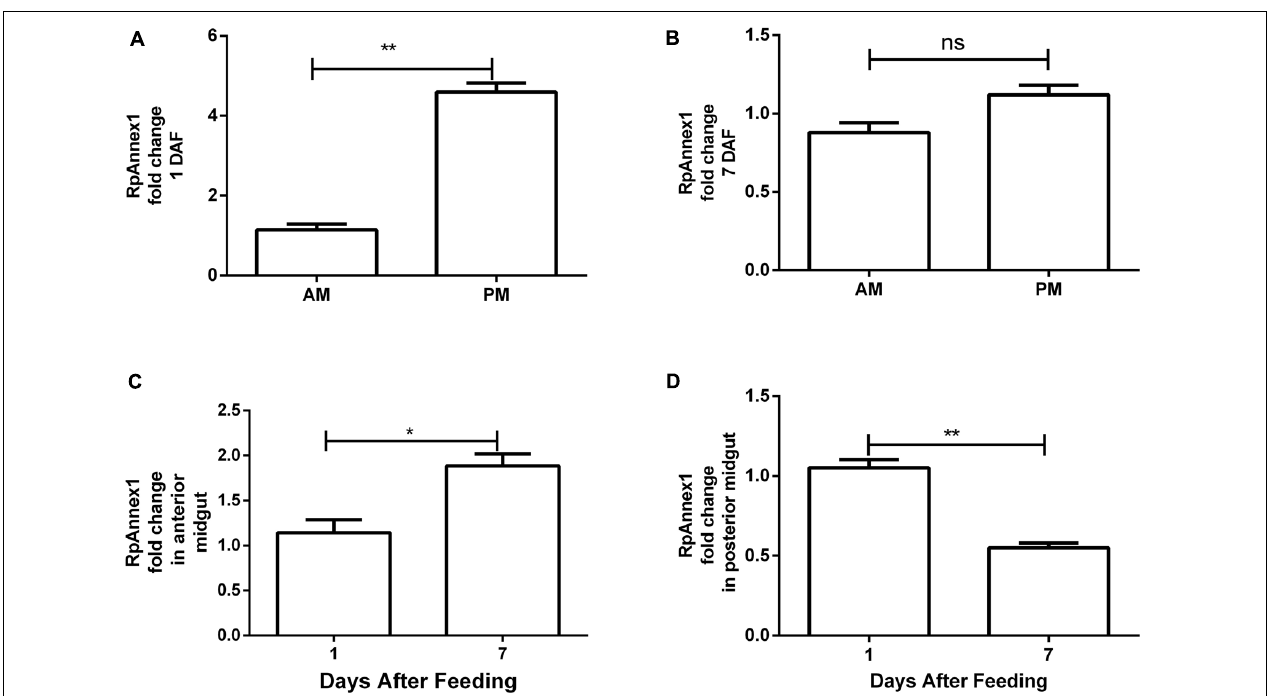
FIGURE 6 | Spatial and temporal relative gene expression of RPRC011897 (RpAnnex1) in fifth instar nymphs of R. prolixus . Blood-fed insects were dissected, and the digestive tract was separated in anterior midgut (AM) and posterior midgut (PM) at 1 and 7 days after feeding (DAF). (A) Expression of RpAnnex1 in AM and PM at 1 DAF. (B) Expression of RpAnnex1 in AM and PM at 7 DAF. (C) Expression of RpAnnex1 in AM at 1 and 7 DAF. (D) Expression of RpAnnex1 in PM at 1 and 7 DAF. Calibrators genes used in the relative quantification of gene expression were α -tubulin and GAPDH . Bars represent the mean ± the standard error of the mean (SEM) of two independent experiments with three pools of R. prolixus ( n = 3). Means were compared applying Student’s t -test; ** p < 0.01, * p < 0.05, and ns stands for